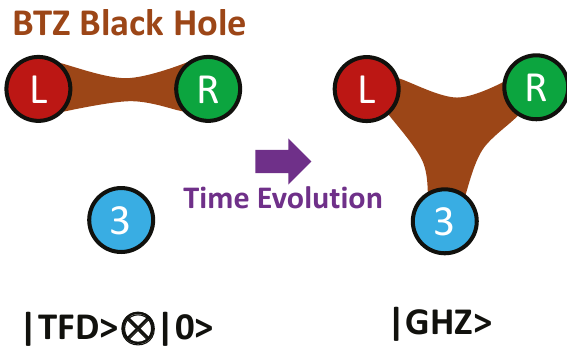
Figure 6. A sketch of time evolution from a thermo(cid:12)eld state into GHZ state in